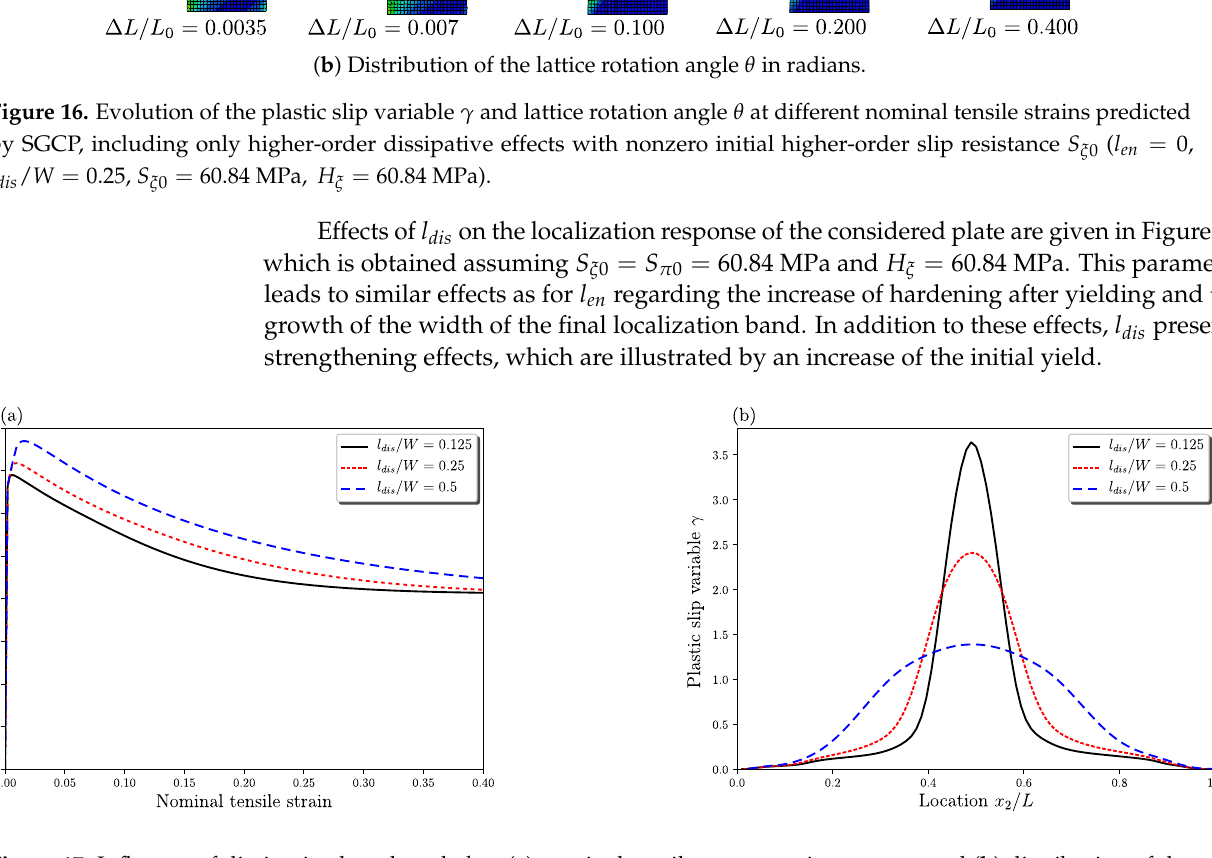
Figure 17. Influence of dissipative length scale l dis : ( a ) nominal tensile stress–strain response and ( b ) distribution of the plastic slip variable γ along the x 2 direction at ∆ L / L 0 = 0.4 ( l en = 0, S ξ 0 = 60.84 MPa, H ξ = 60.84